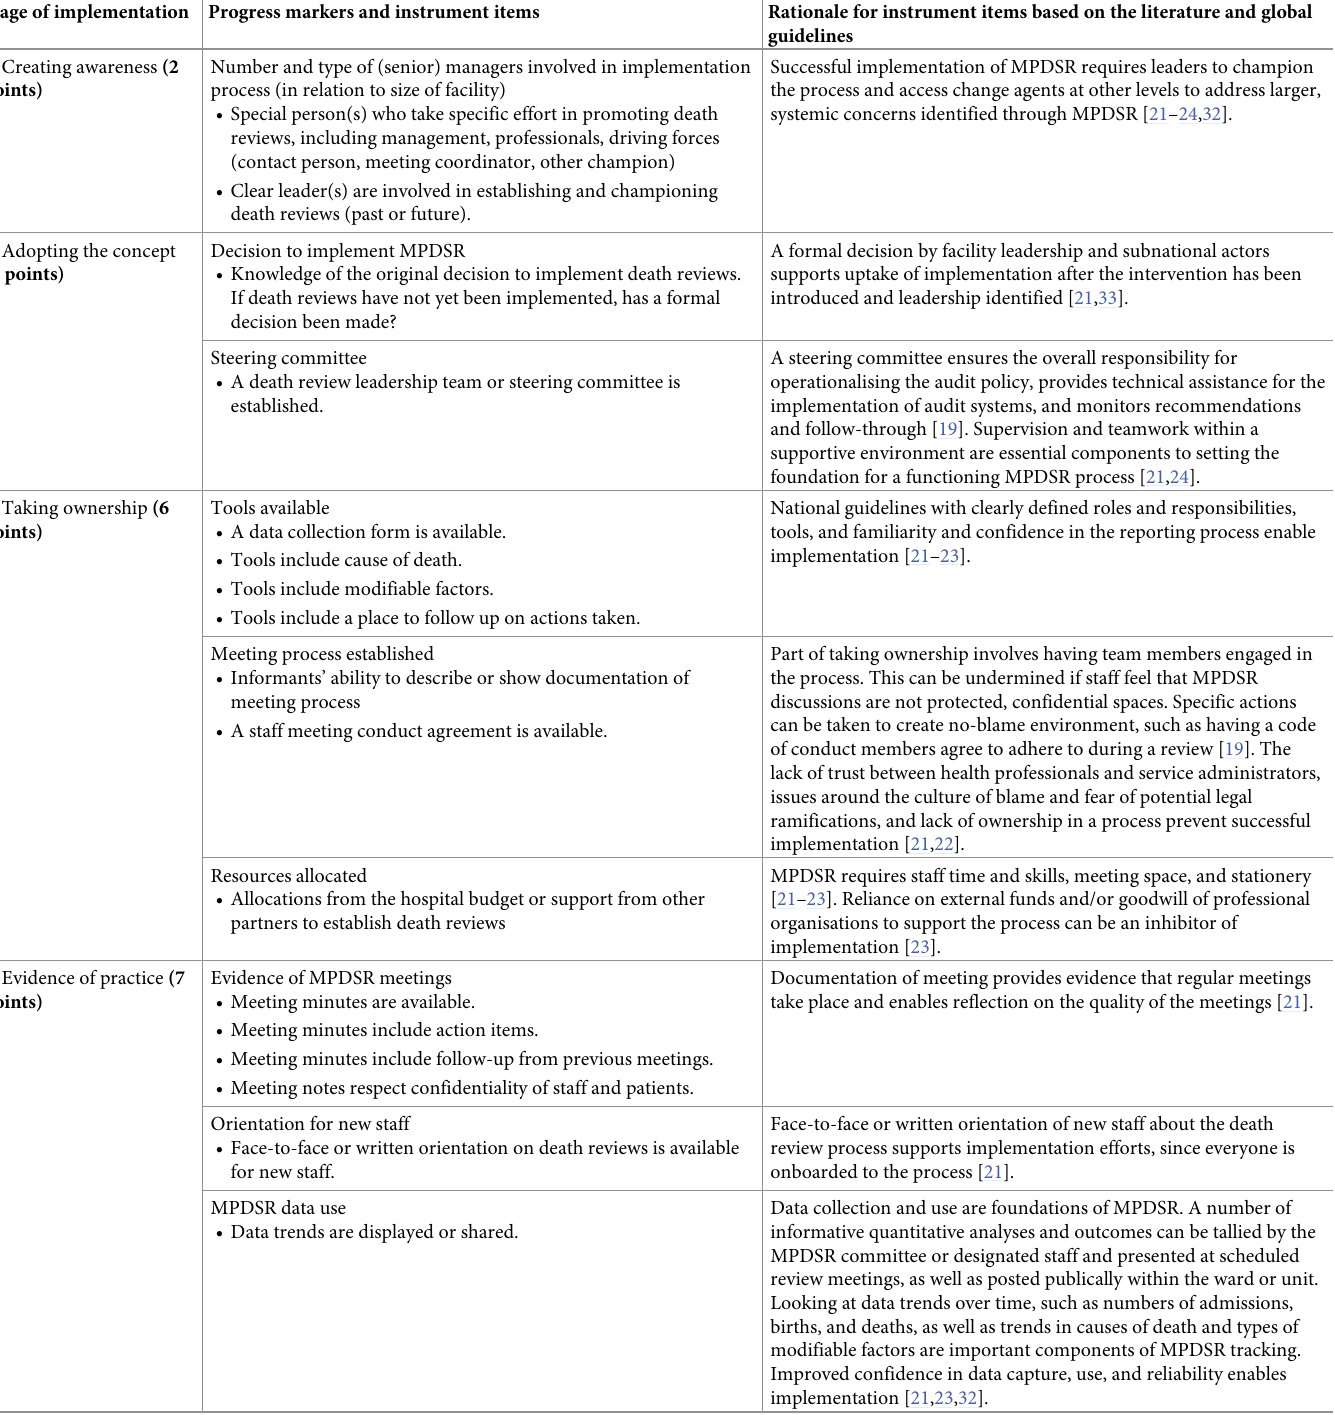
Table 3. Progress markers and rationale for assessing. Stage of implementation Progress markers and instrument